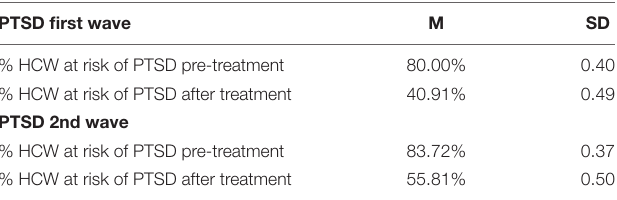
TABLE 4 | Analysis of the risk for Post-Traumatic Stress Disorder (PTSD) pre- and post-treatment in the two emergency waves. PTSD first wave M